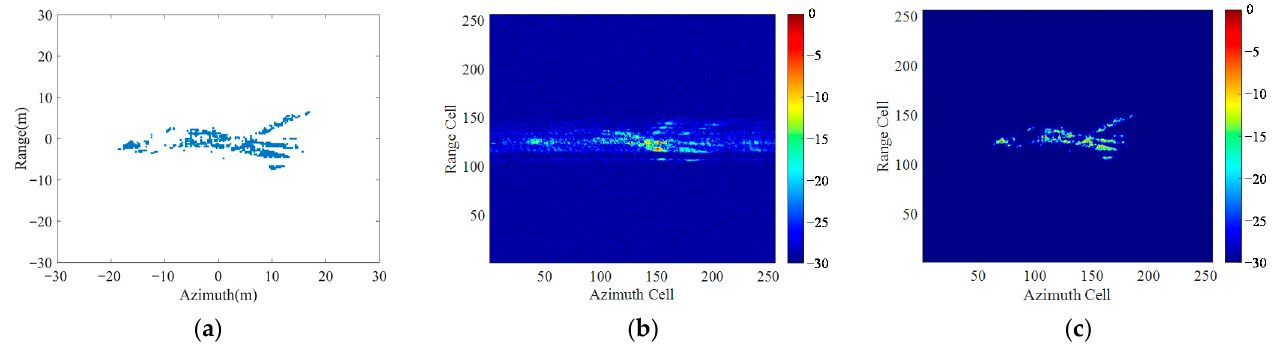
Figure 15. An example of the training data: ( a ) The coordinate distribution of the scattering points on the block target; ( b ) The blurred ISAR image as the input of UFGAN; ( c ) The ideal image as the label of the UFGAN.